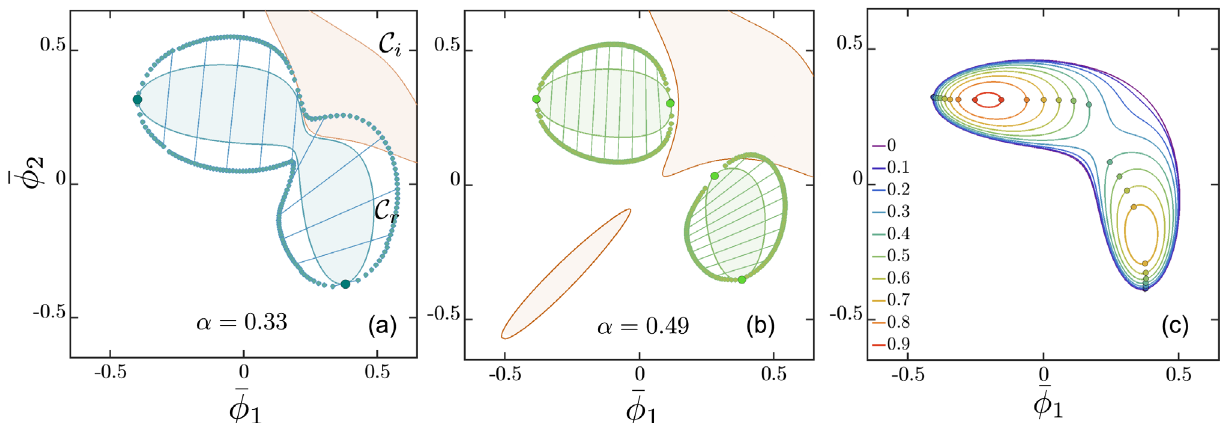
¯ ϕ ; ¯ ϕ FIG. 2. Bulk phase separation in the plane of average composition ð 1 2 Þ . (a) The spinodal region, the binodal region, the tie lines, and the two critical points are shown for α ¼ 0 . 33 . The homogeneous state is unstable to small perturbations inside the spinodal region shaded in blue. (b) At higher activity, α ¼ 0 . 49 , the spinodal region splits into two disconnected regions shaded in green. Both regions are surrounded by binodal regions and have developed two new critical points. (c) Change in spinodals and critical points with increasing α . Splitting into two disconnected regions occurs for α > 0 . 35 . Parameters used in the free energy are c 1 ; 1 ¼ 0 . 2 , c 1 ; 2 ¼ 0 . 5 , c 0 . 1 , c 0 . 5 , χ ¼ − 0 . 2 and χ 0 ¼ 0 . 2 , κ ¼ 0 . 001 . A system size of 201 × 201 and a time stepping of 10 − 4 are used in all of the 2 ; 1 ¼ 2 ; 2 ¼ simulations to construct the